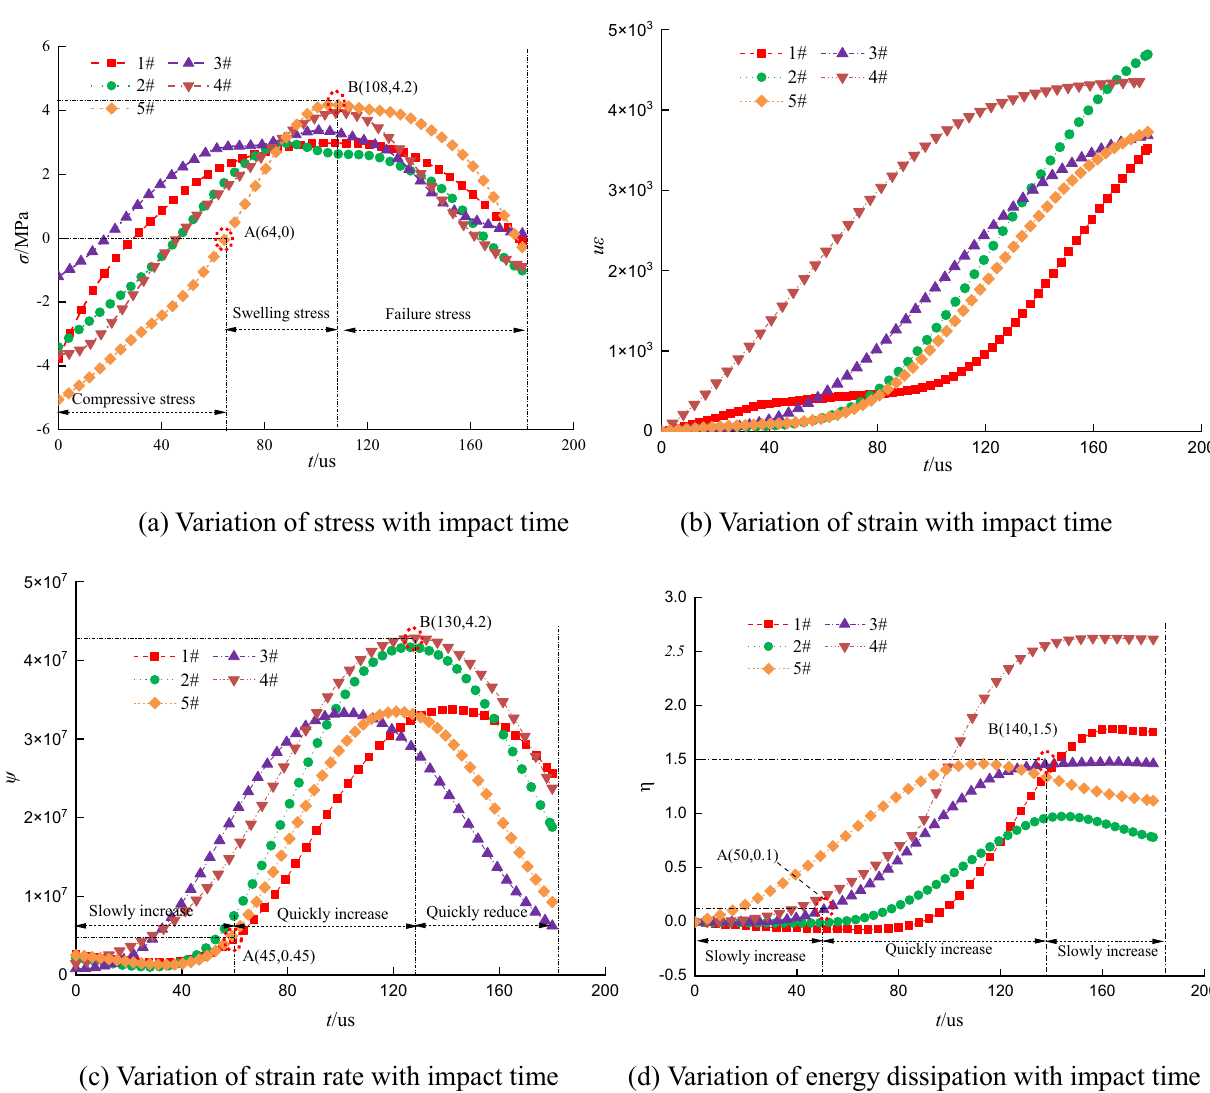
Fig. 2 Dynamic mechanical characteristics of coal with a water content of 0%. a Variation of stress with impact time; b Variation of strain with impact time; c Variation of strain rate with impact time; d Variation of energy dissipation with impact